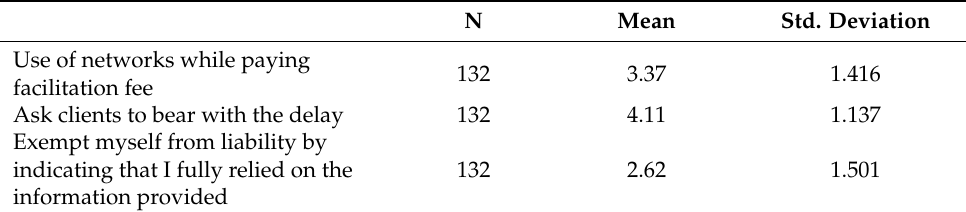
Table 11. Valuer’s response to poor land information management systems.